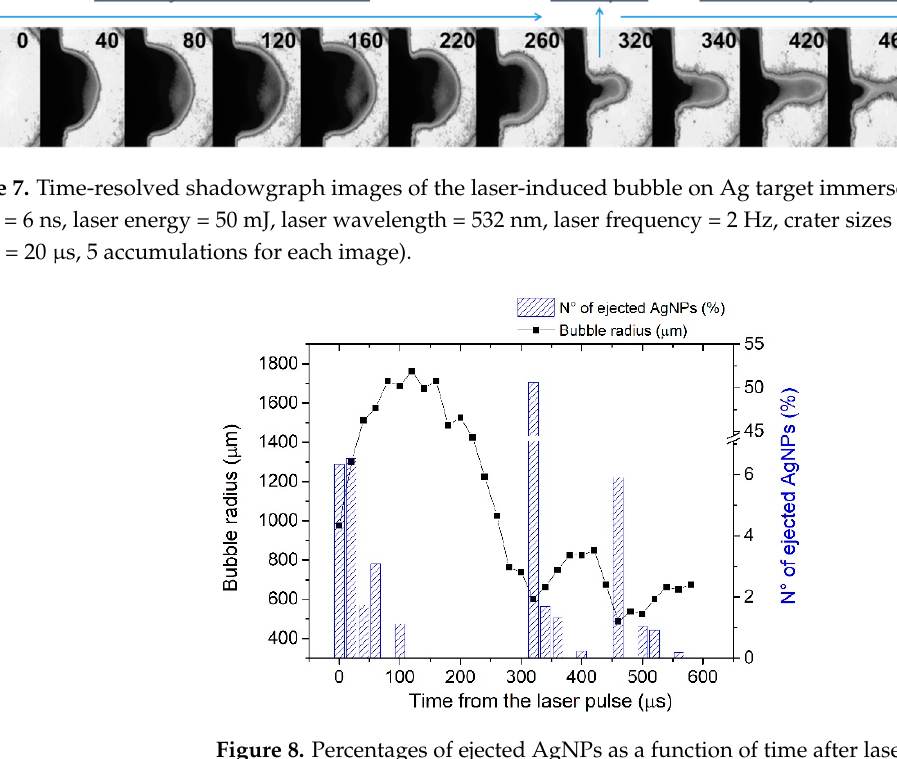
Figure 8. Percentages of ejected AgNPs as a function of time after laser pulse and the corresponding bubble radius evolution. (Laser pulse width = 6 ns, laser energy = 50 mJ, laser wavelength = 532 nm, laser frequency = 2 Hz, crater sizes = 1 ± 0.2 mm, ICCD gate width = 20 µ s, estimated initial AgNPs number = 2e10).